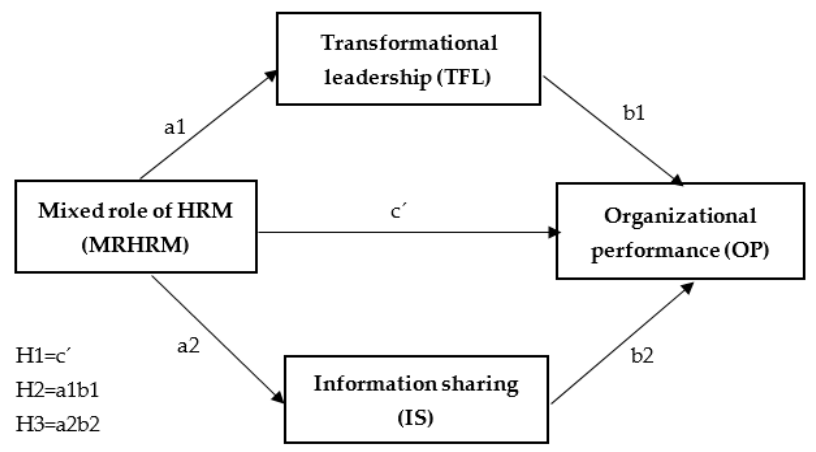
Figure 1. The mediation model and the 3 tested